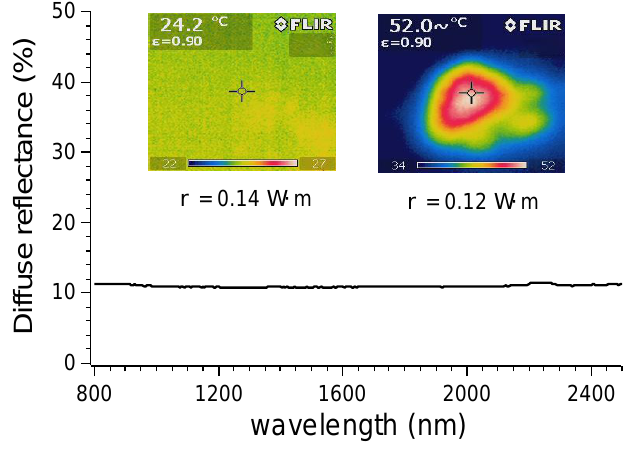
Figure 8. Diffuse reflectance of PK30PMA 8 wt % nanocomposite and thermal images before and after exposure to IR light for 30 min.